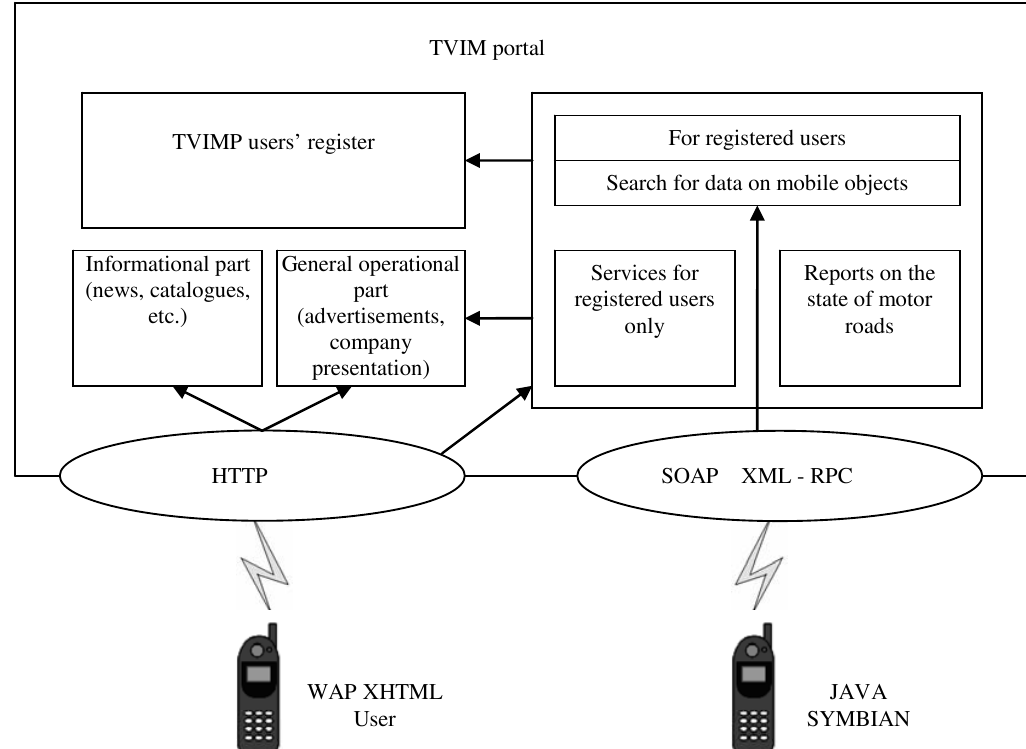
Fig 4 . Changes made in the portal pages to support the mobile